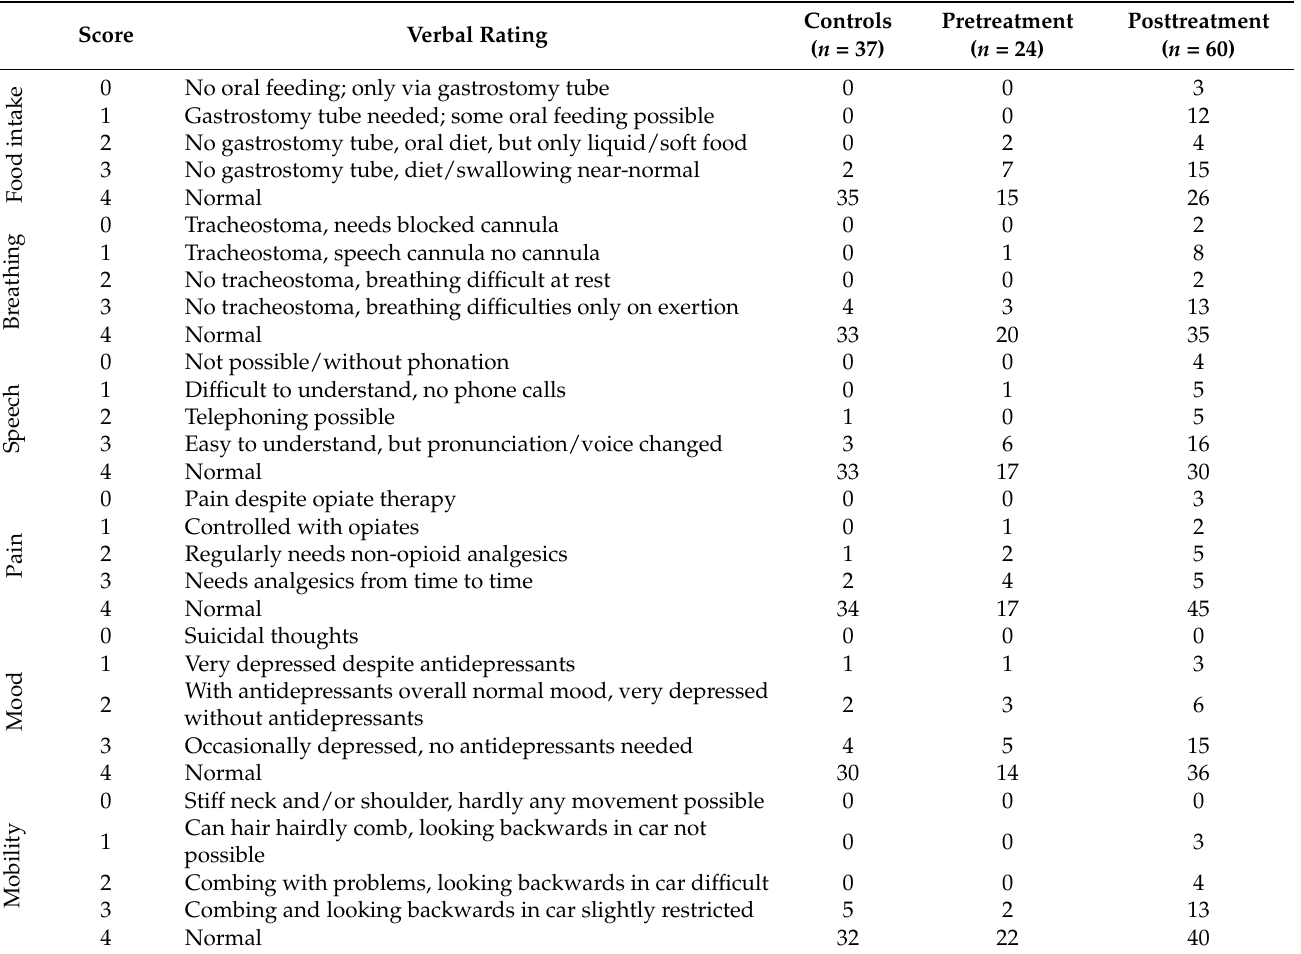
Table 6. Frequencies of HNC-FIT verbal